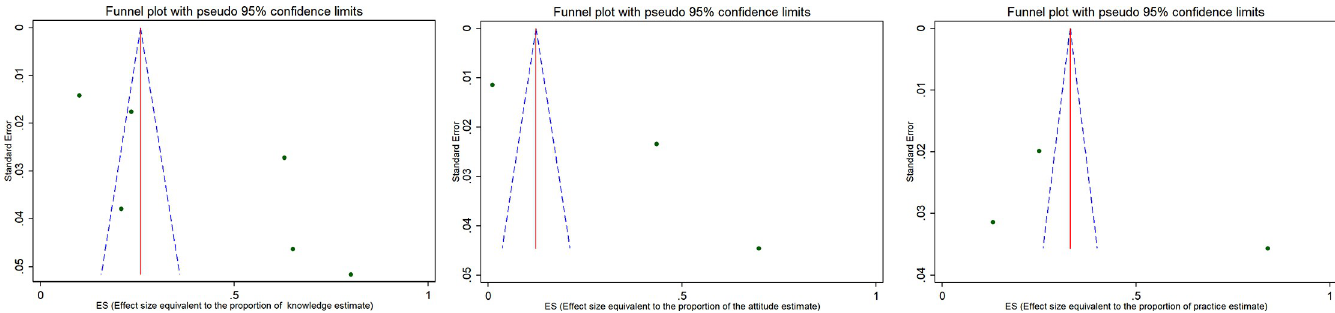
Fig 5. Publication bias assessment: a) Funnel plot of the 6 estimates of knowledge (k) towards cervical cancer screening available for meta-analysis (SE-Standard error, ES-Effect size: proportion), b) Funnel plot of the 3 estimates of attitude (A) towards cervical cancer screening available for meta-analysis (SE-Standard error, ES-Effect size: proportion), c) Funnel plot of the 3 estimates of practice towards cervical cancer screening available for meta-analysis (SE-Standard error, ES-Effect size: proportion). In this plot, the blue broken line indicates Pseudo 95% CI, the solid red line indicates pooled estimate of the proportion of knowledge, attitude and practice, and the scattered circle dots indicates included studies in the meta-analysis. The scale on the X-axis indicates Effect size estimate or proportion and the Y-axis indicates the precision estimate using standard Error.